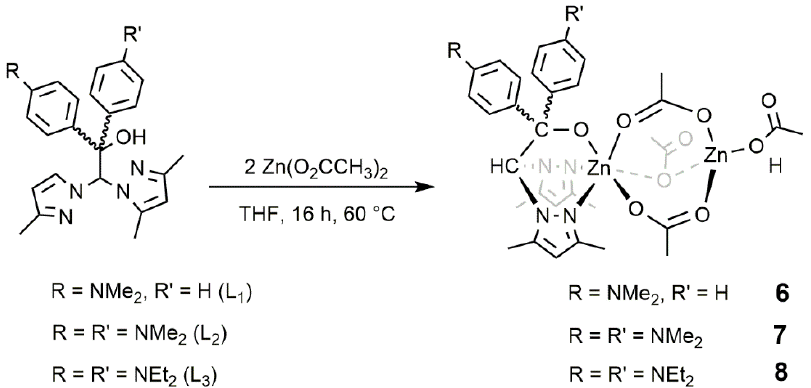
Figure 4. Synthesis of bimetallic zinc acetate catalysts 6 − 8 supported by heteroscorpionate ligands [27].